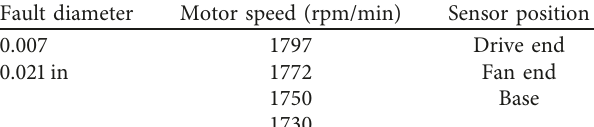
Table 11: Different conditions statement of 24 groups data. Fault diameter